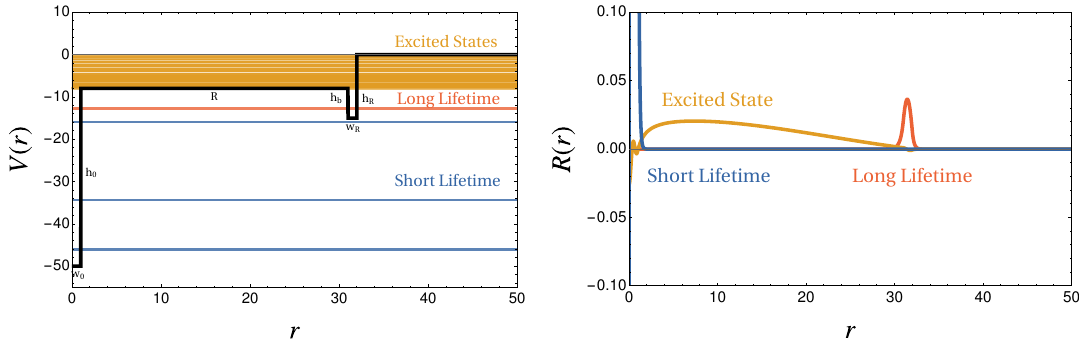
, the potential energy V is in unit χ